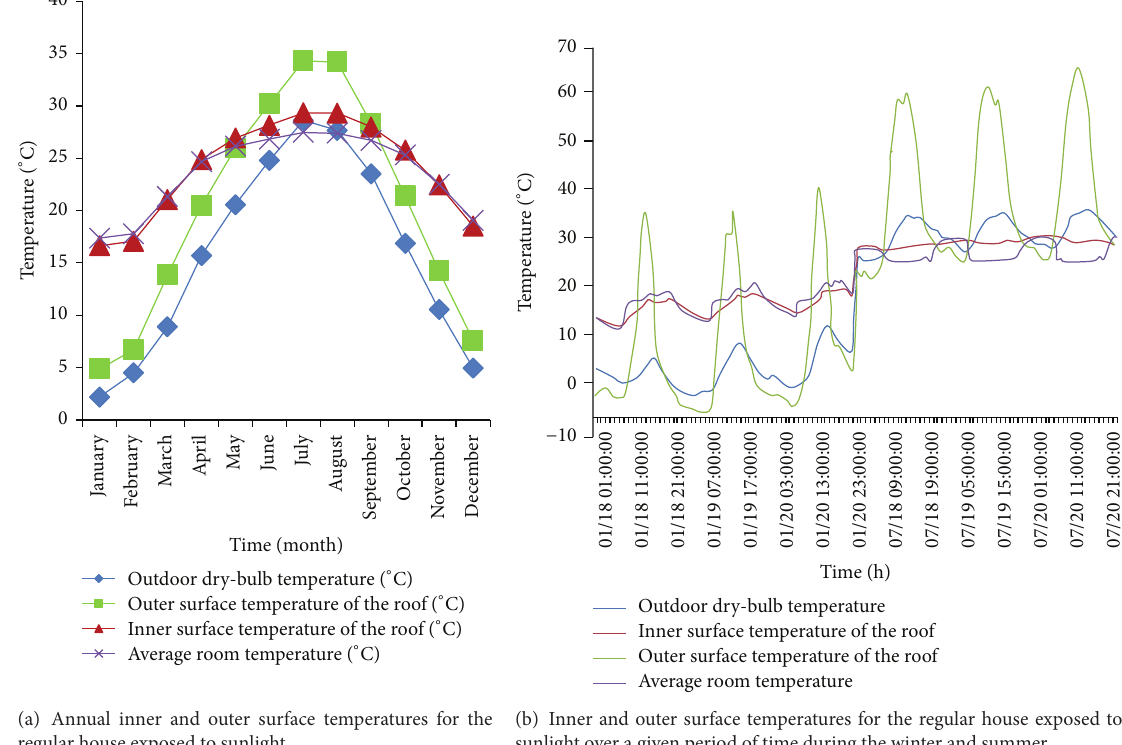
(b) Inner and outer surface temperatures for the regular house exposed to sunlight over a given period of time during the winter and summer Figure 6: Simulated inner and outer surface temperatures for the regular house exposed to sunlight.